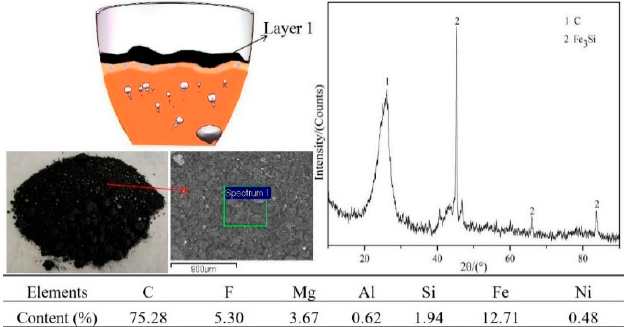
Figure 6. XRD pattern and energy-dispersive X-ray spectroscopy (EDS) analysis of Layer 1.